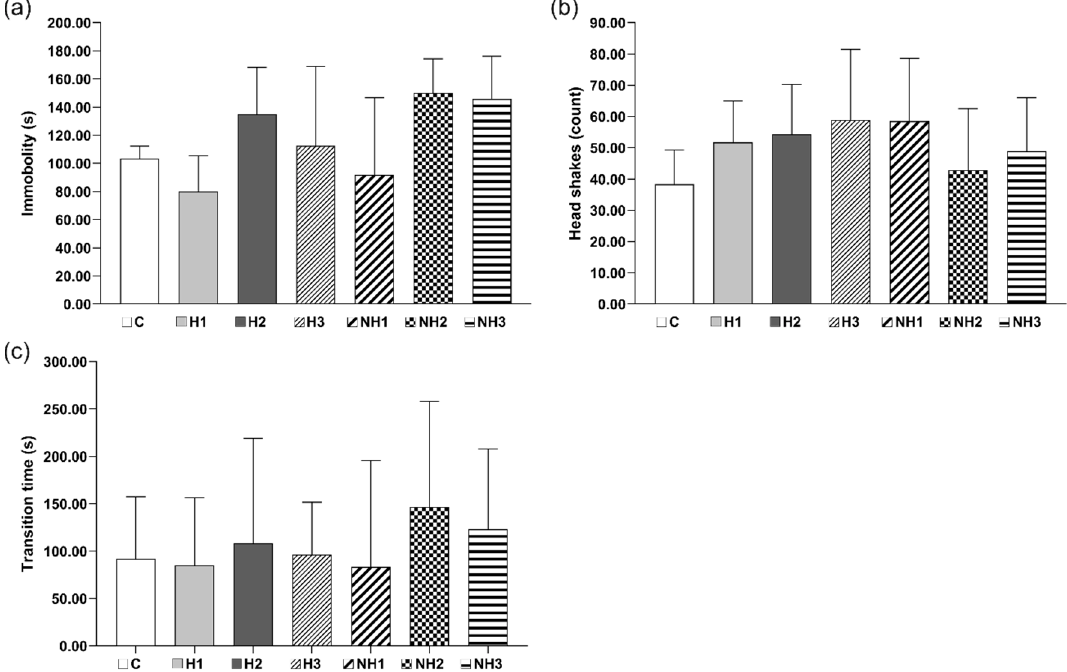
Figure 1. Behavioral tests: ( a ) Porsolt test: mean time of immobility, ( b ) Porsolt test: mean number of head shaking, ( c ) orientation and spatial memory test: mean time transition through the maze. Samples: C = control, H1 = 10 µ g H / kg, H2 = 15 µ g H / kg, H3 = 20 µ g H / kg, NH1 = 8 µ g NH / kg, NH2 = 12 µ g NH / kg, NH3 = 16 µ g NH / kg. Number of animals in all groups n = 6.